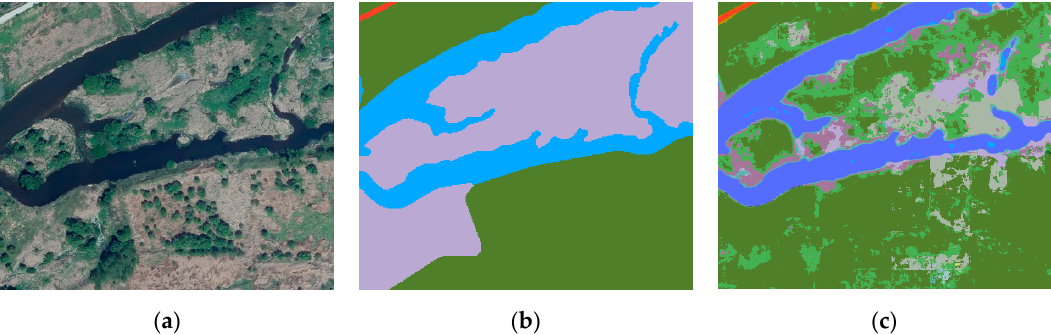
Figure 10. Example of ambiguity of land cover in wetland and barren lands (purple is wetland, gray is barren lands, green is grass land, blue is river, red is road). ( a ) Orthographic image 1, ( b ) Land cover map 1, ( c ) Classification result 1.